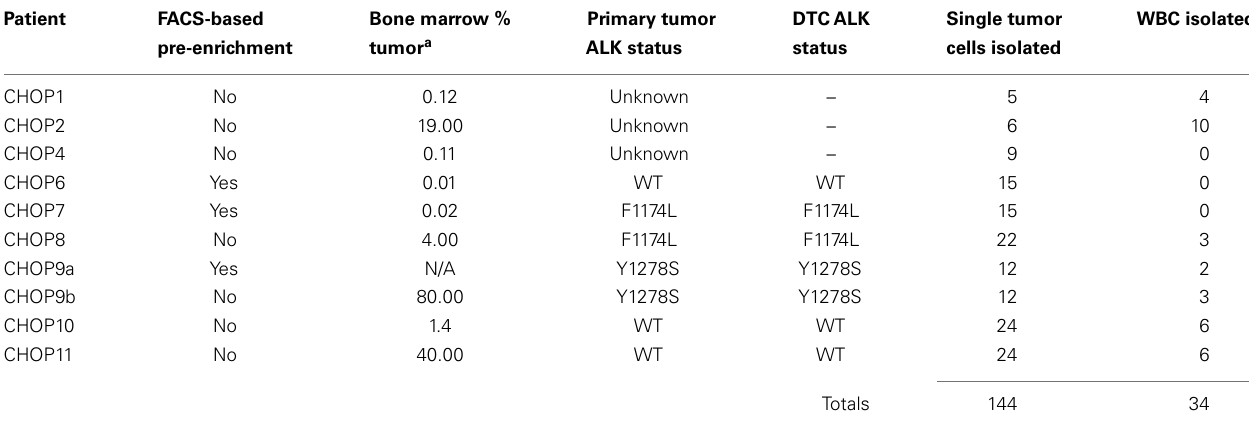
Table 2 | Summary of single DTCs collected from neuroblastoma patient bone marrow samples